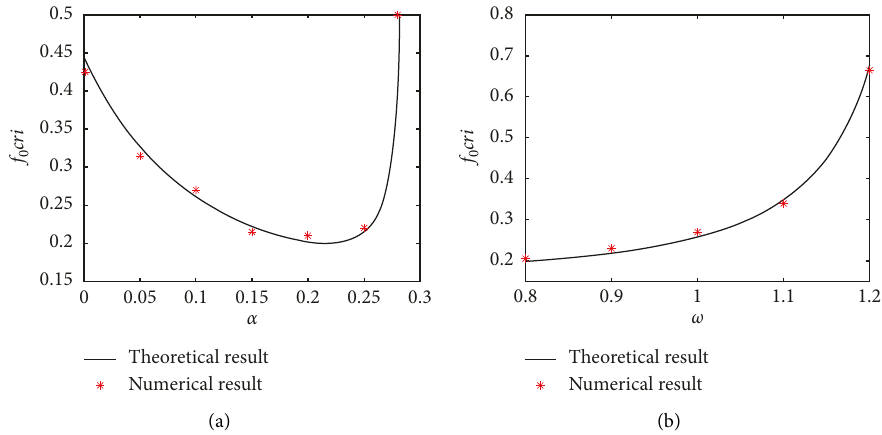
Figure 10: Variation of the thresholds of f